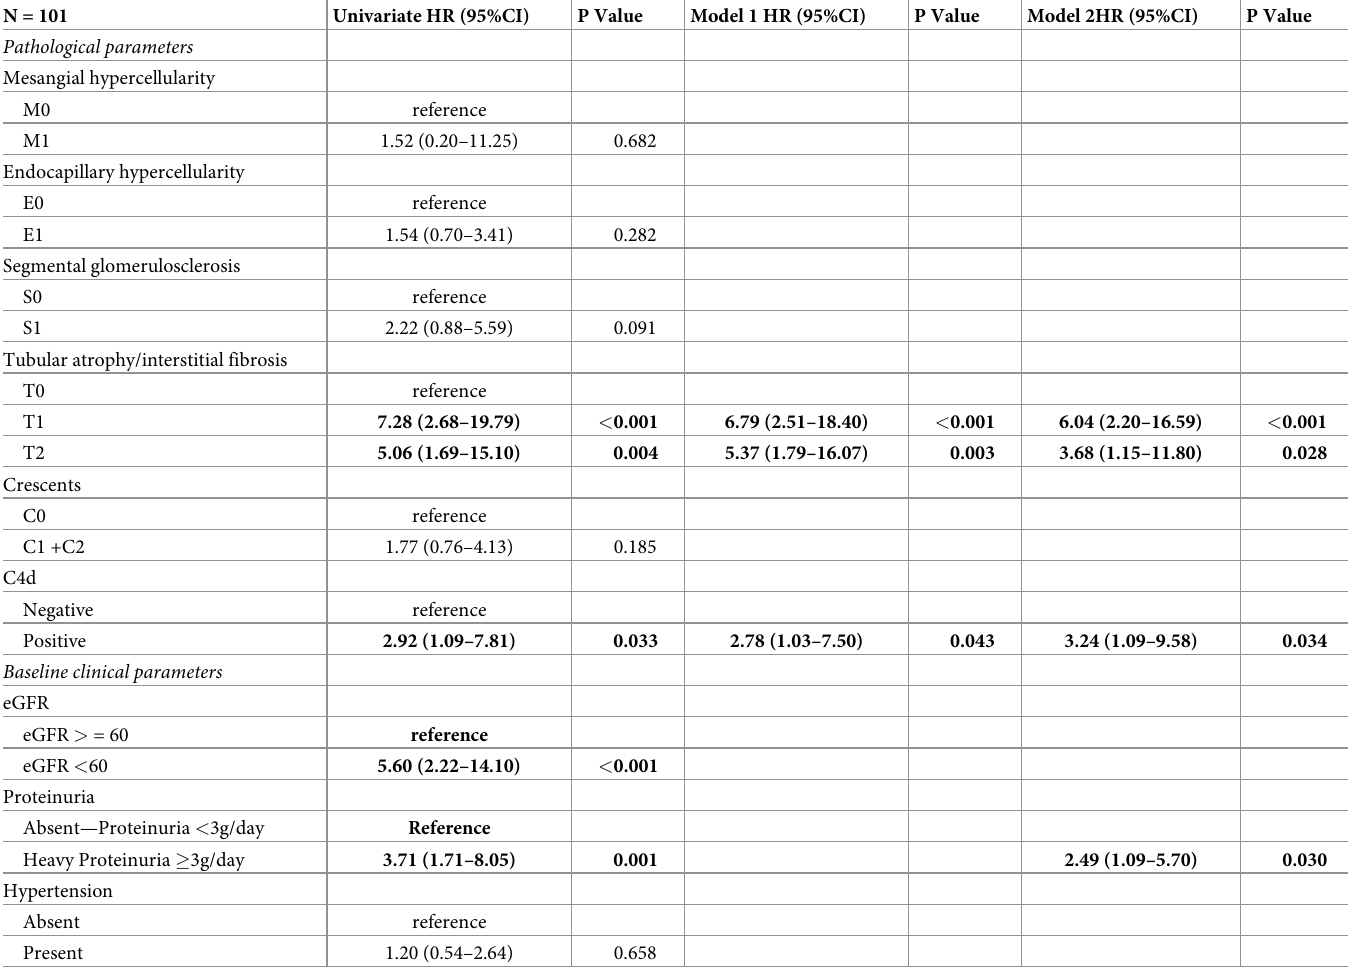
Table 3. Multivariate analysis of clinicopathological parameters on primary outcome (Kidney Failure or Δ